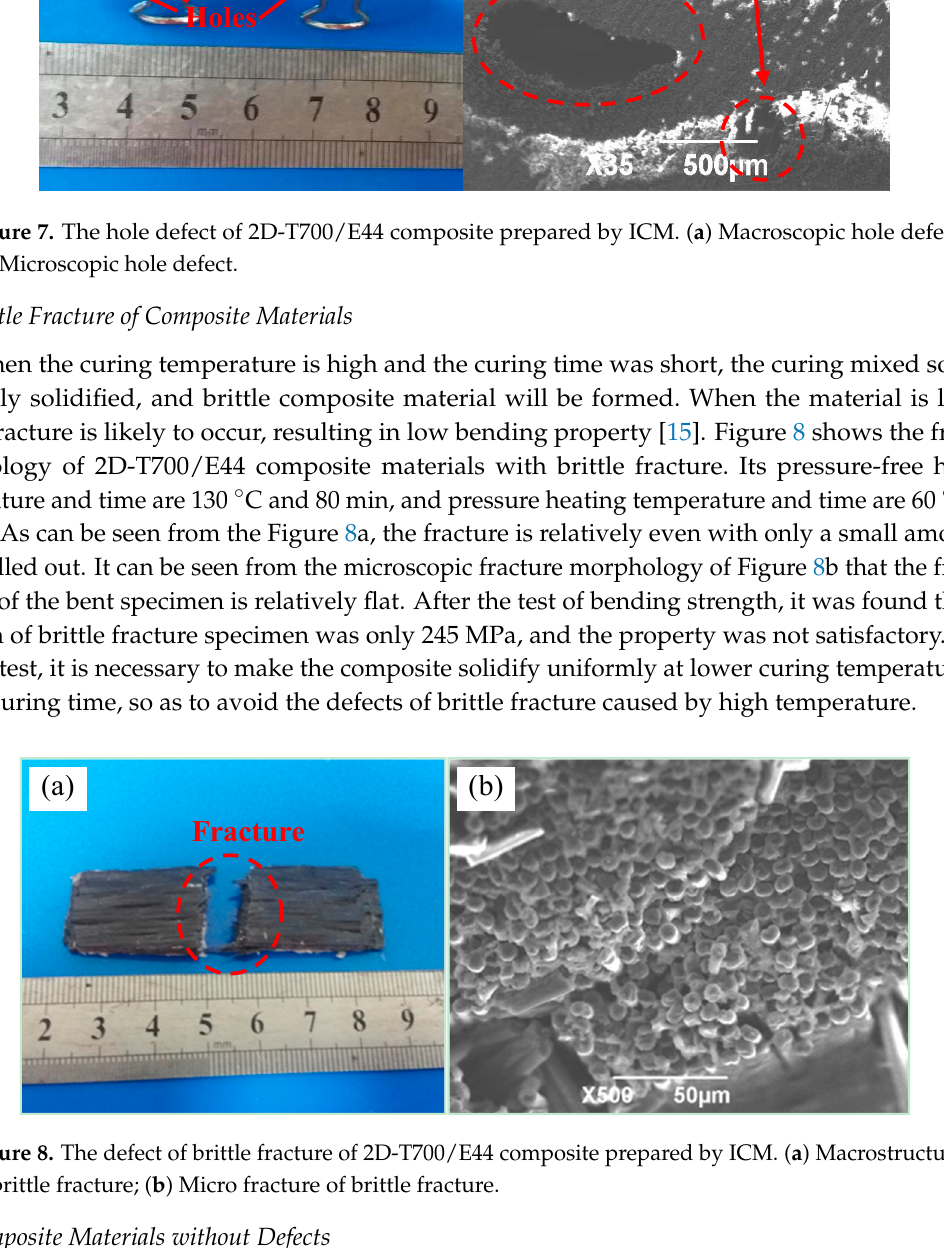
Figure 7. The hole defect of 2D-T700/E44 composite prepared by ICM. ( a ) Macroscopic hole defect; ( b ) Microscopic hole defect.